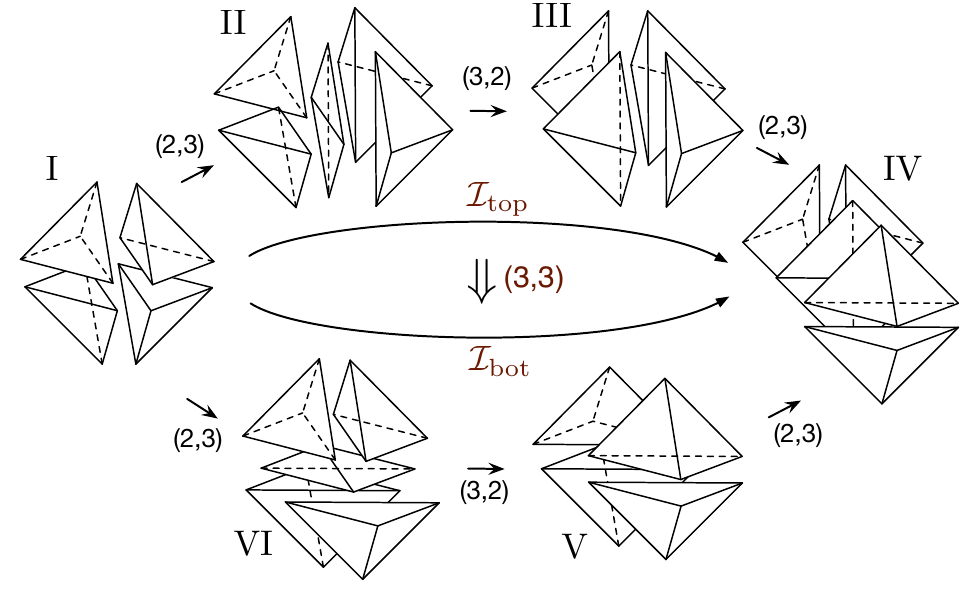
Figure 1 . The (3,3) Pachner move relates two sequences of (2,3) and (3,2) Pachner moves applied to triangulated octahedra. In (cid:12)eld theory, it relates two composite interfaces the 3d = 2 theories I and IV associated to octahedra on the far left and right of this (cid:12)gure. N Each side (cid:13)ows to four fermi multiplets nontrivial permutation of (cid:13)avor